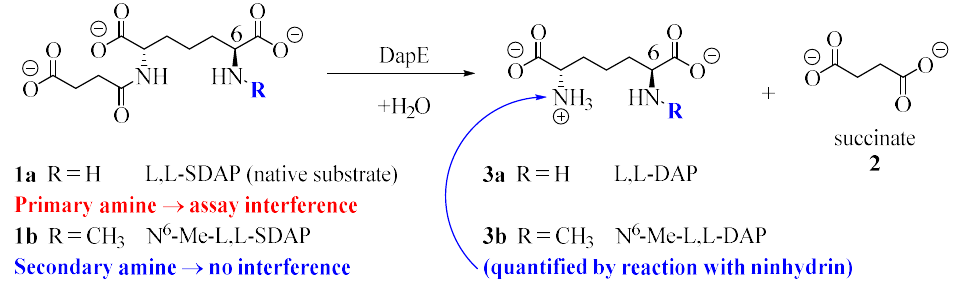
Figure 1. Hydrolysis of N- succinyl- L , L -diaminopimelic acid ( L , L -SDAP) and N 6 -Me-SDAP by Hi DapE. L , L -SDAP ( 1a ) and N 6 -methyl SDAP analog ( 1b ) and with the formation of hydrolysis products succinate ( 2 ) and L , L -diaminopimelic acids ( L , L -DAP) ( 3a , b ).